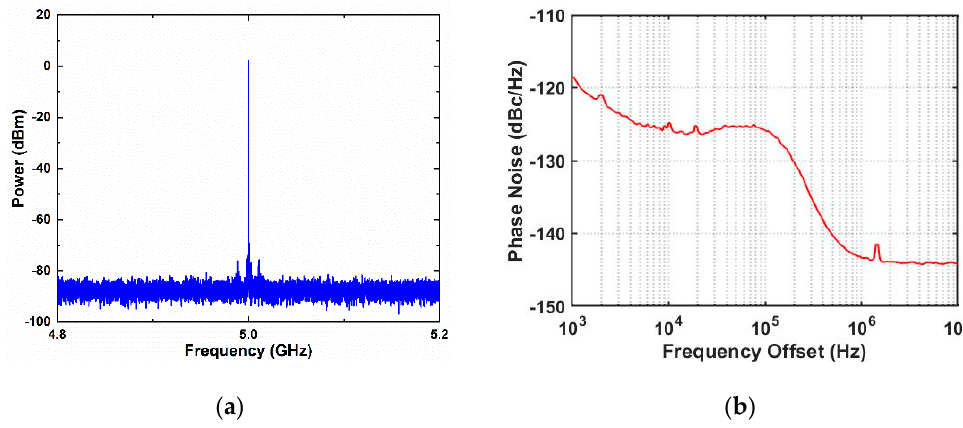
Figure 7. Measurement results of the 5-GHz single-tone signal from the microwave source. ( a ) The spectrum. ( b ) The phase noise curve.